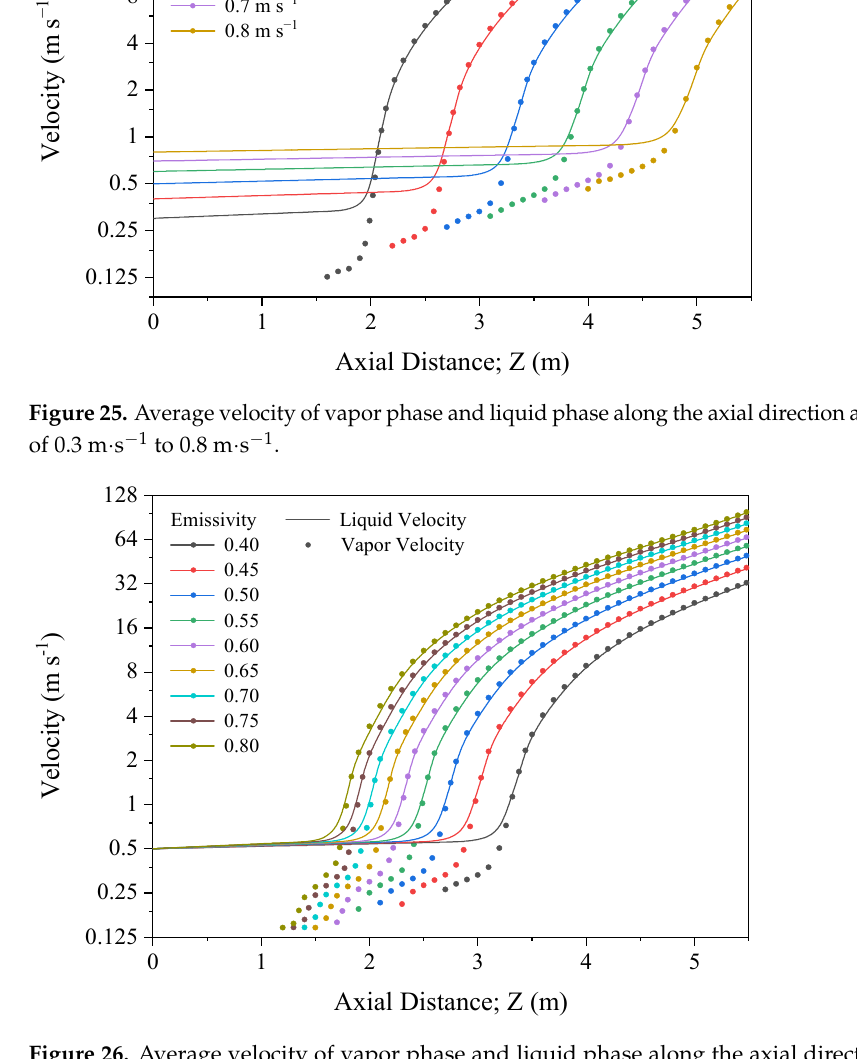
Figure 26. Average velocity of vapor phase and liquid phase along the axial direction under wall emissivity of 0.40 to 0.80.